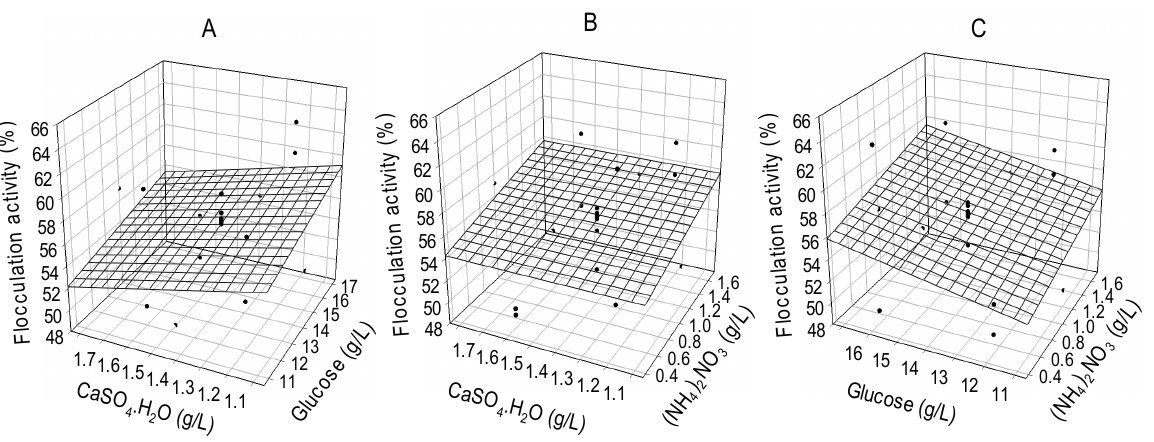
Figure 1. Three dimensional representations of interactions of critical media components after flocculation activity optimization following application of surface response